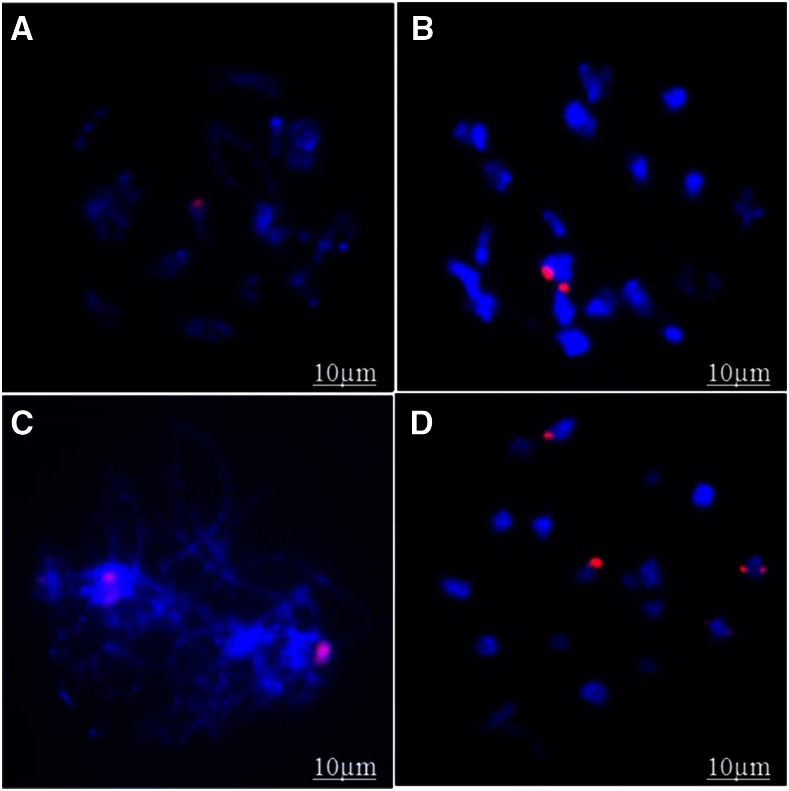
GISH signals showing the substituted B-genome fragment(s) in B. napus introgression lines, (A) IL16 at metaphase, (B) IL75 at metaphase, (C) IL69 at pachytene, (D) IL59 at metaphase. All 19 A-/C-genome chromosomes are characterized by blue color due to staining with DAPI. B-genome chromosome introgressions are expressed in red color due to labeling with B-genome specific probe.